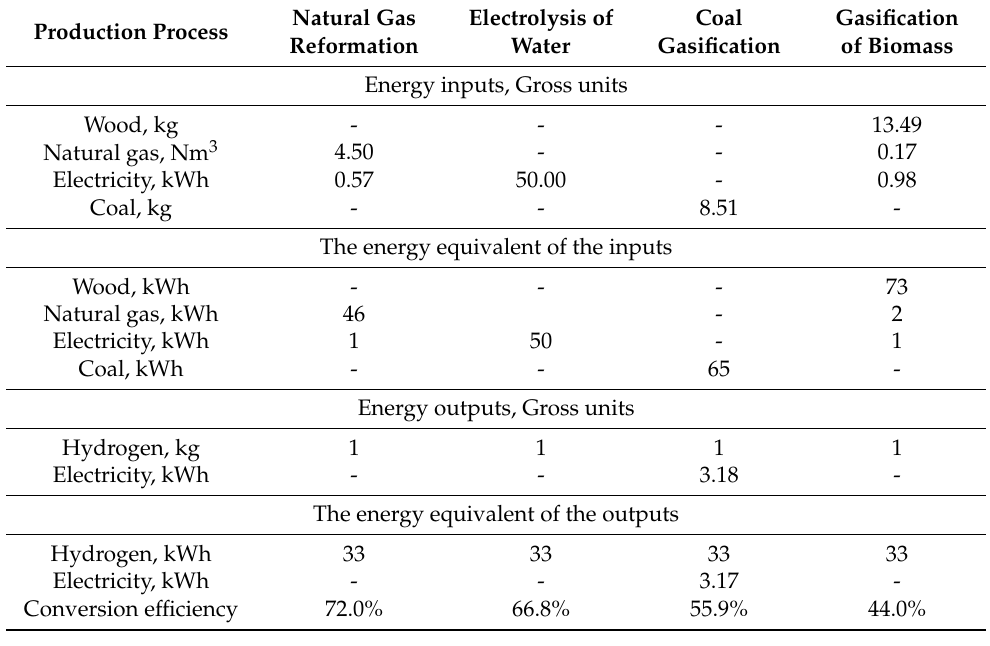
Table 2. The efficiency of technologies [9].